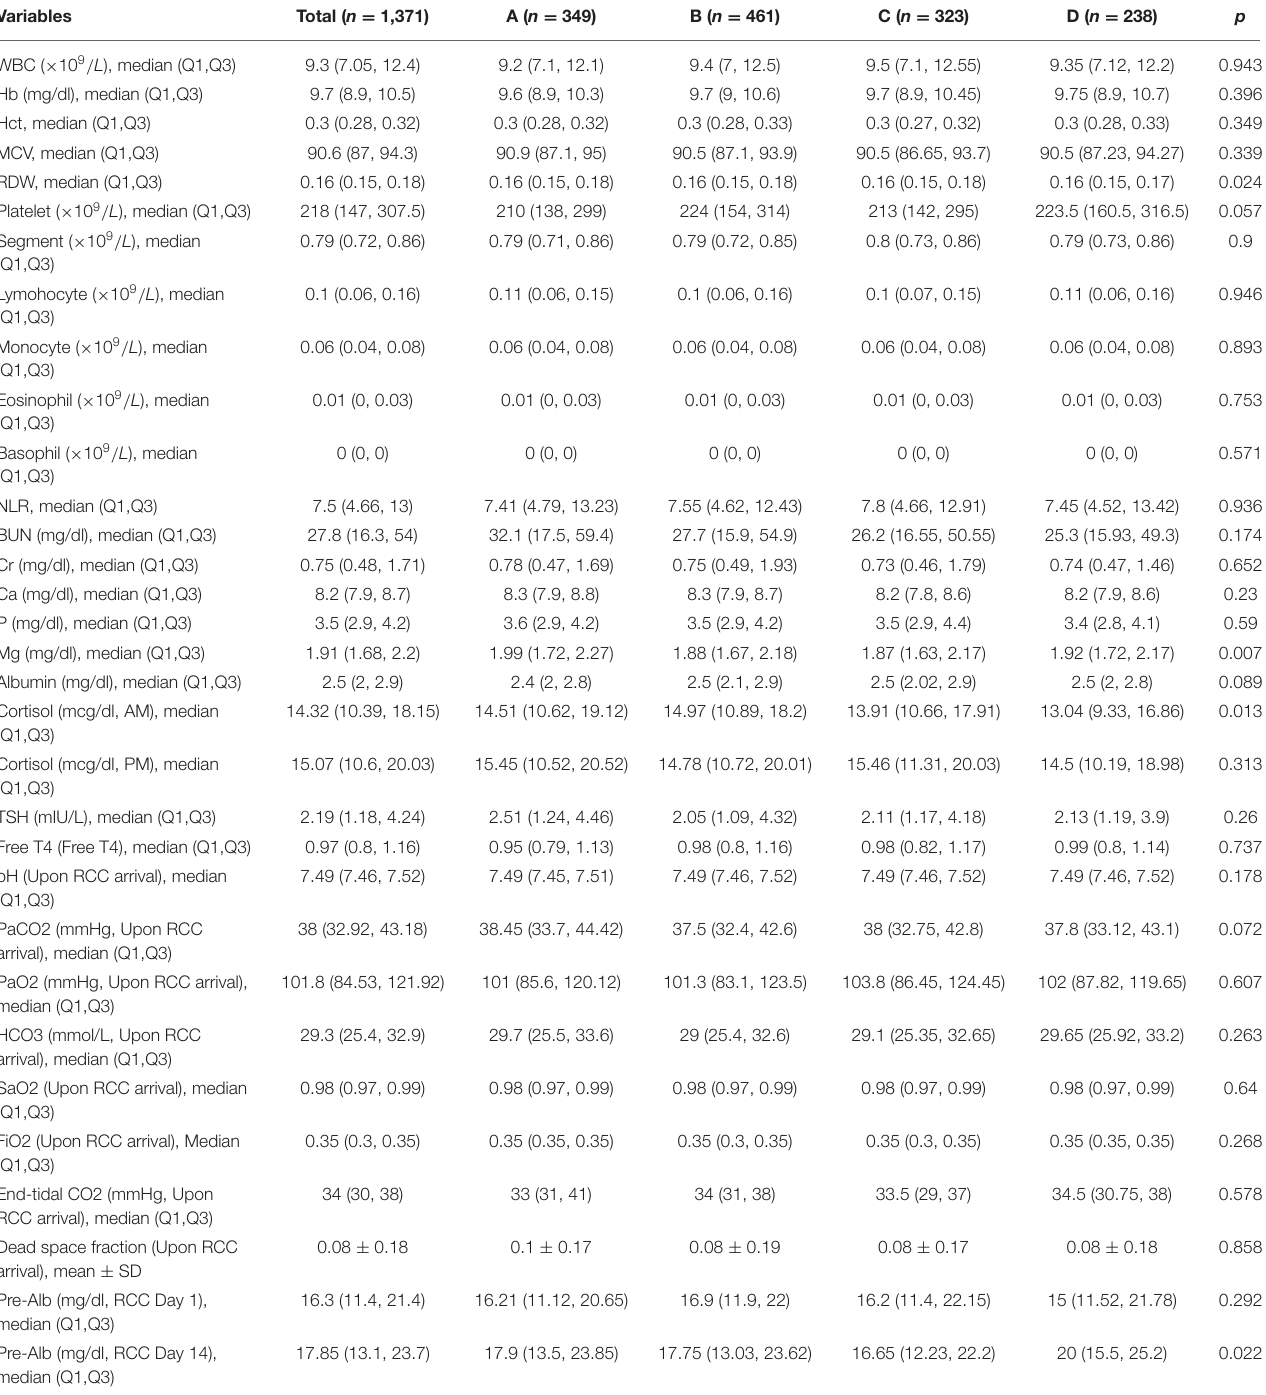
TABLE 2 | Laboratory findings on RCC entry.